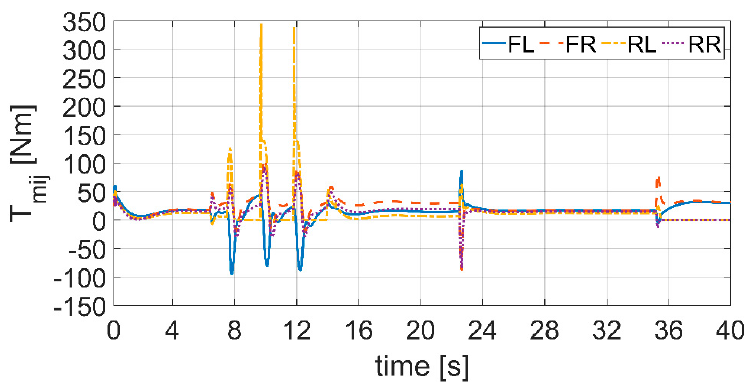
Figure 22. Bending on Low-Friction Patch: ( a ) steering wheel angle δ sw ; ( b ) yaw-rate tracking r .